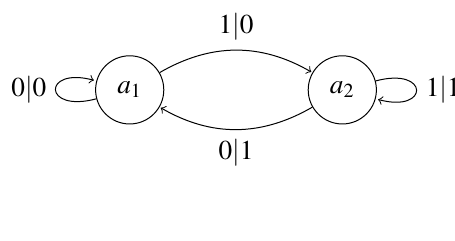
Figure 1: A transducer over X